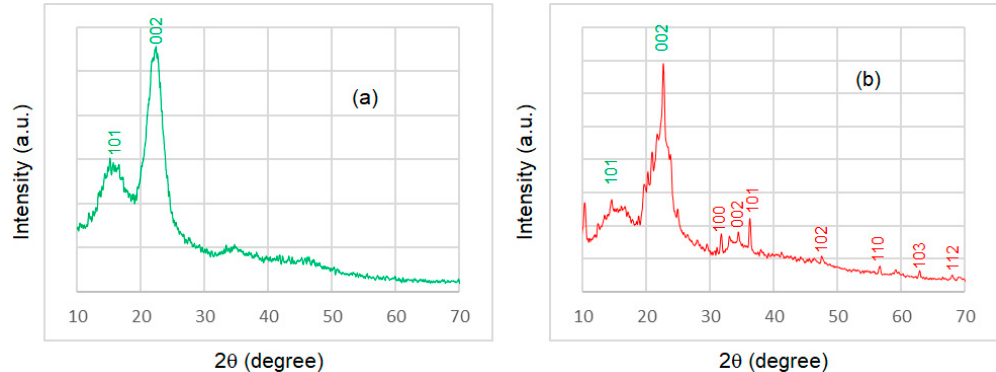
Figure 5. EDX patterns of the ( a ) uncoated wood (sample S1) and ( b ) epoxy@ZnO coated wood (sample (sample S3).